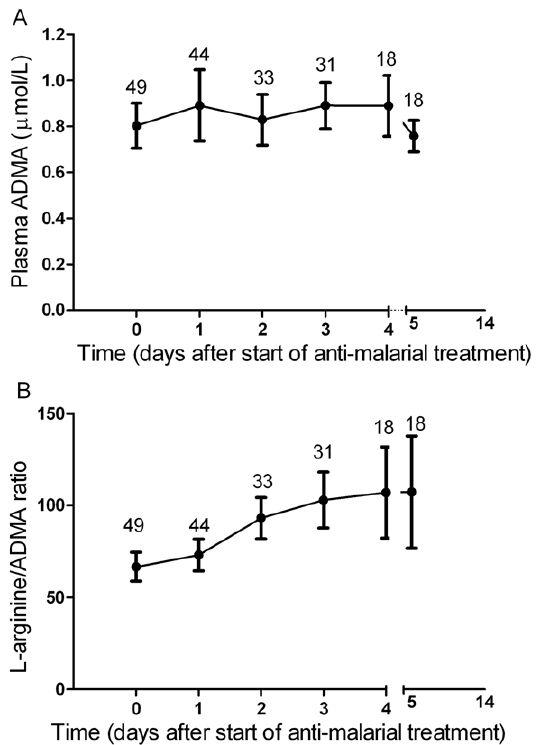
Figure 1. Plasma dimethylarginine concentrations in each group on enrollment (ANOVA: p , 0.001). A. Plasma asymmetric dimethylarginine (ADMA) concentrations in each group on enrollment (ANOVA: p , 0.001). In the severe malaria group, open circles represent fatal cases and closed circles survivors. Horizontal lines indicate mean for each group. B. Plasma symmetric dimethylarginine (SDMA) concentrations in each group on enrollment (ANOVA: p , 0.001). In the severe malaria group, open circles represent fatal cases and closed circles survivors. Horizontal lines indicate mean for each group.